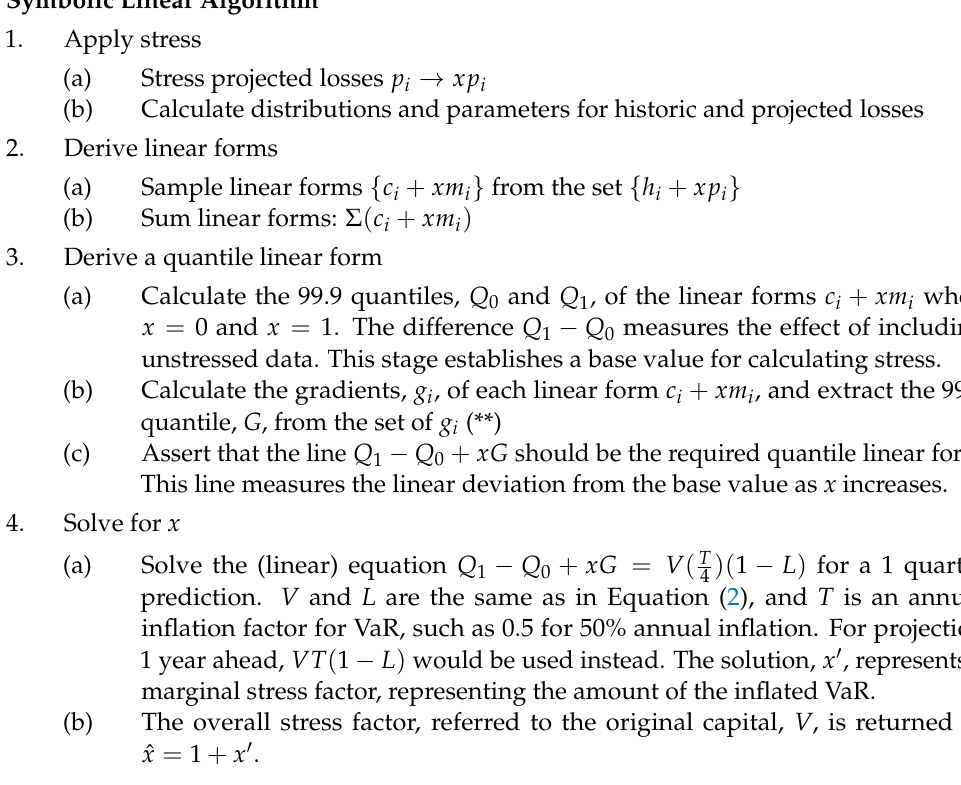
Algorithm Symbolic Linear 499